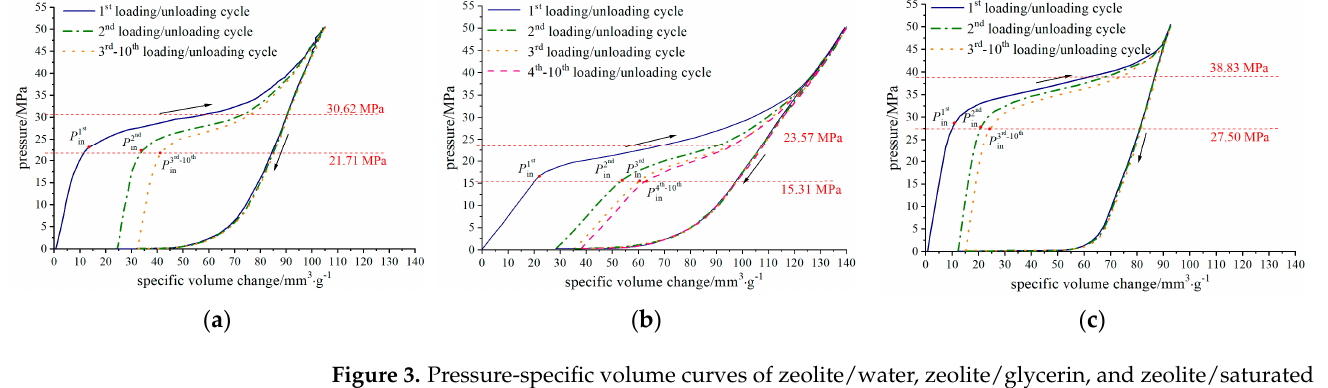
Figure 3. Pressure-specific volume curves of zeolite/water, zeolite/glycerin, and zeolite/saturated KCl solution stuffing (zeolite here refers to ZSM-5 zeolite, where zeolite and the functional liquid are blended according to 1 g to 10 mL): ( a ) zeolite/water stuffing; ( b ) zeolite/glycerin stuffing; ( c ) zeolite/saturated KCl solution